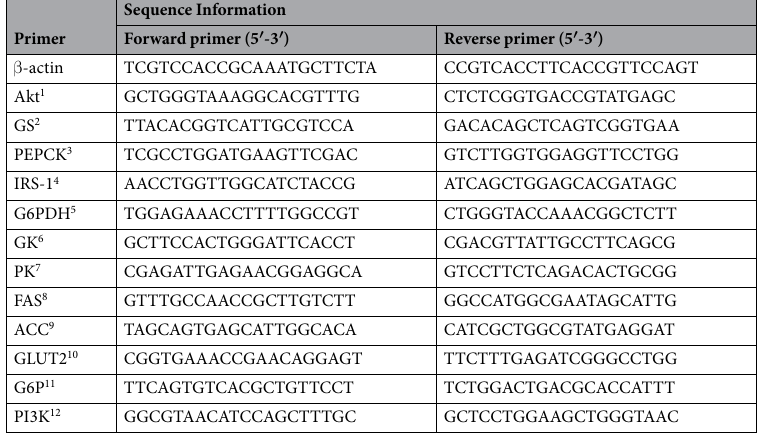
Table 2. Primer sequences for qRT-PCR analysis. Note: 1 Akt: Protein kinase B; 2 GS: Glycogensynthase; 3 PEPCK: Phosphoenol pyruvate carboxykinase; 4 IRS-1: Insulin receptor substrate 1; 5 G6PDH: Glucose- 6-phosphate dehydrogenase; 6 GK: Glucokinase; 7 PK: Pyruvate kinase; 8 FAS: Fatty acid synthase; 9 ACC: Acetyl CoA carboxylase; 10 GLUT2: Glucose transporter 2; 11 G6P: Glucose 6-phosphatase; 12 PI3K: Phosphoenolpyruvate